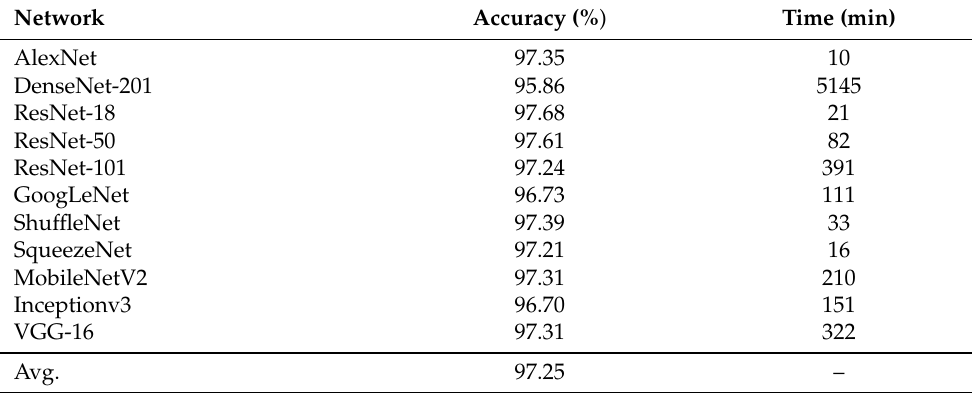
Table 2. Accuracy and training times of CNNs on NIH with preprocessing